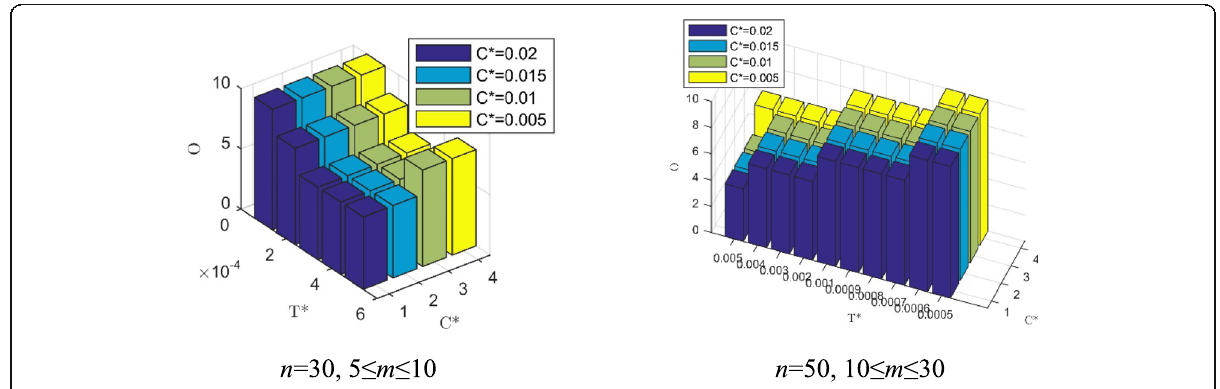
Fig. 11 User storage overhead under various values of T * and C